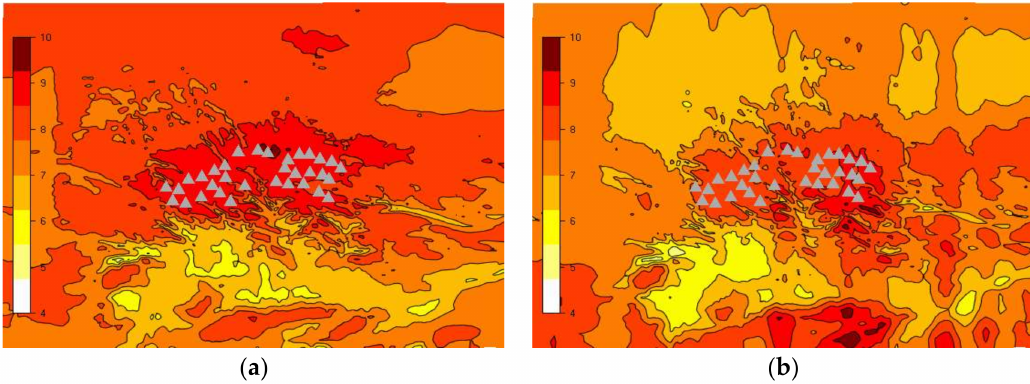
Figure 6. Velocity field distributions under different inflow wind directions (unit: m/s): ( a ) North wind; ( b ) South